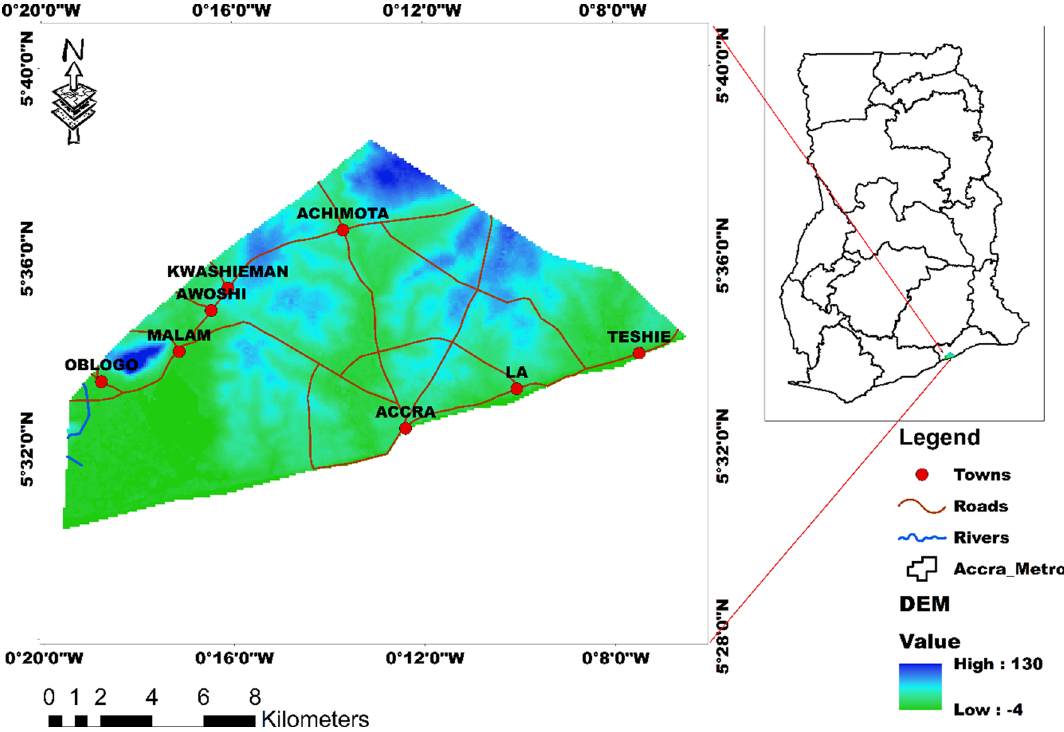
Fig. 1 Location map of the study